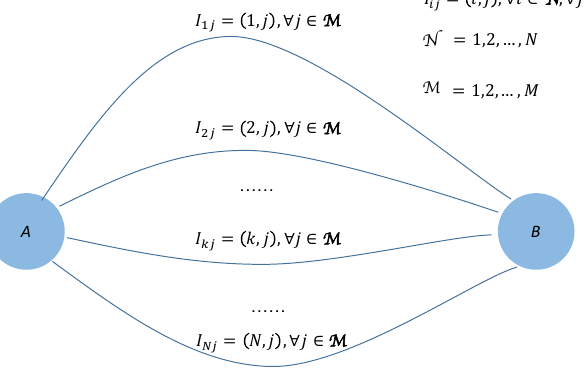
Figure 1. Rule-based Incentive Framework (RIF) model: travellers competing to select incentives between two traffic